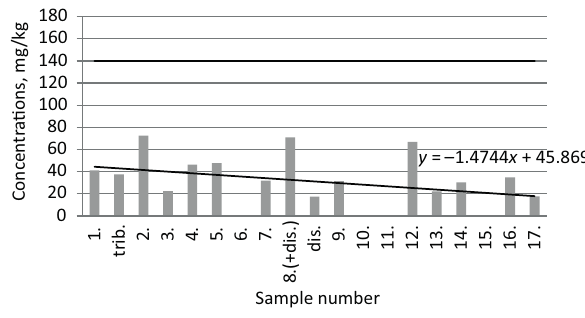
Fig. 7. Cr concentrations on the right bank, downstream trend ( y ), the concentration of the I sludge category (bold